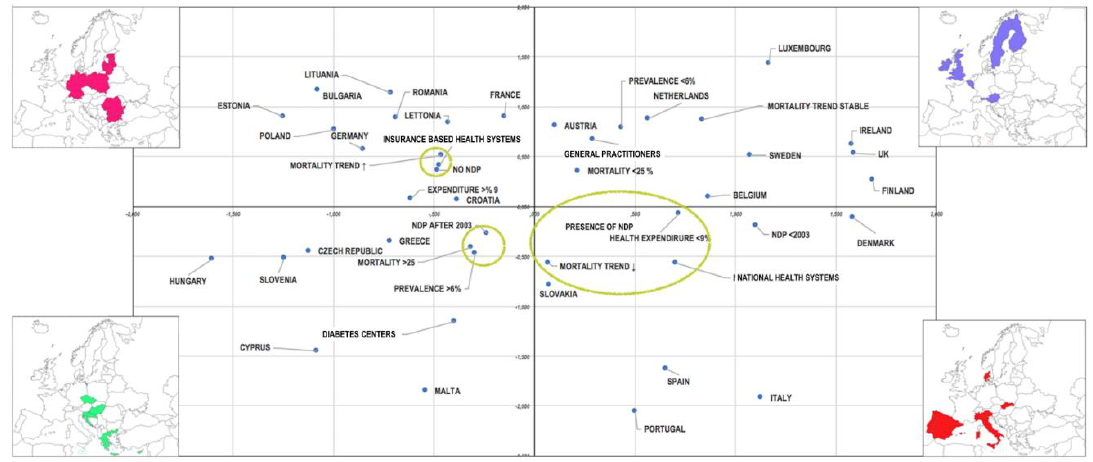
Figure 4. Multiple correspondence analysis. Graphical representation of the possible associations between the variables taken into consideration.